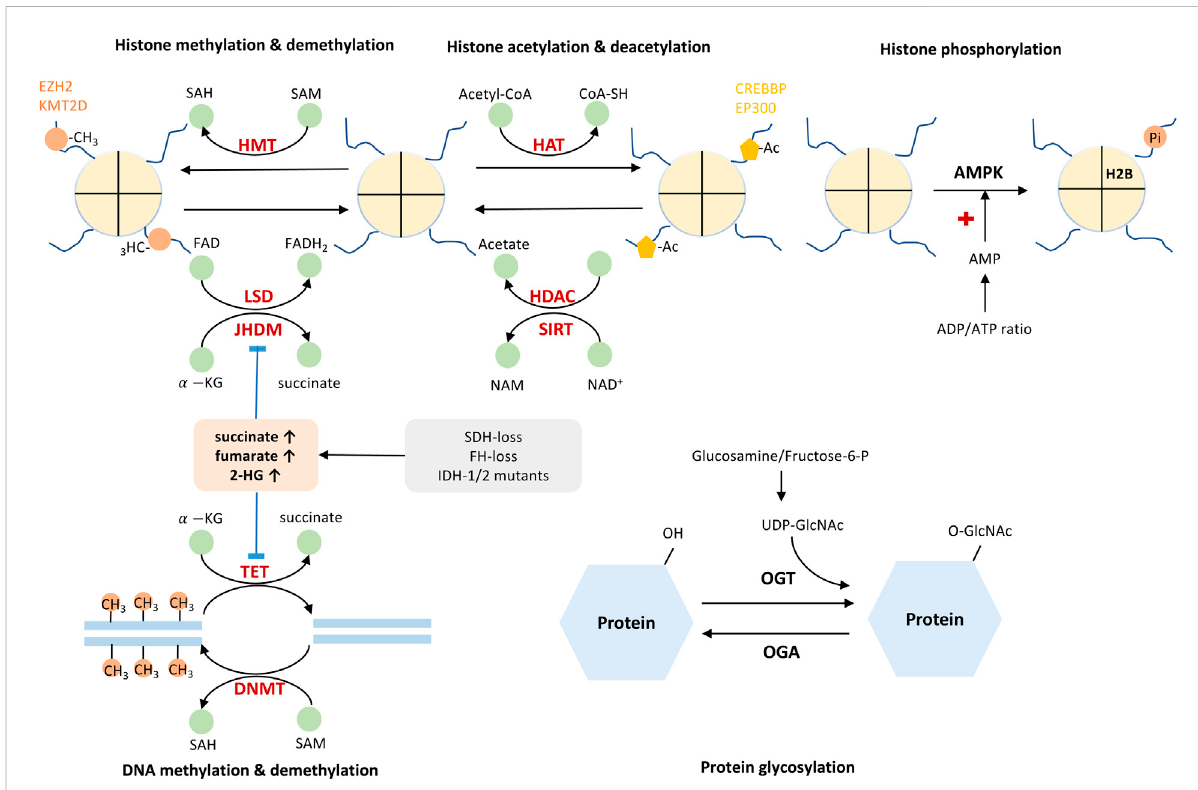
FIGURE 2 Cellular metabolites serve as co-factors or substrates for epigenetic enzymes. Addition or removal of epigenetic marks is catalyzed by epigenetic enzymes, of which process relies on several critical metabolites. SAH/SAM, NAD + /NADH, Acetyl-CoA/Co-A, ATP/ADP ratio act as important molecules or signals governing epigenetic modi fi cations. In addition, Metabolites such as succinate, fumarate, 2-HG, and lactate could inhibit the activity of epigenetic enzymes. HMT, histone methyltransferase; LSD, lysine-speci fi c histone demethylase; JHDM, Jumonji domain- containinghistonedemethylase;HAT,histoneacetyltransferase;HDAC,histonedeacetylase;SIRT,sirtuins;DNMT,DNAmethyltransferase;TET,ten- eleven translocation methylcytosine dioxygenase; SAM, S-adenosylmethionine; SAH, S-adenosylhomocysteine; α − KG, α -ketoglutarate; NAM, nicotinamide; NAD + , nicotinamide adenine dinucleotide (oxidized); FAD, fl avin adenine dinucleotide (oxidized); FADH 2 , fl avin adenine dinucleotide (reduced); FH, fumarate hydratase; SDH, succinate dehydrogenase; IDH1/2, isocitrate dehydrogenase 1/2; EZH2, enhancer of zeste 2 polycomb repressive complex 2 subunit; KMT2D, histone-lysine N-methyltransferase 2D. AMPK, AMP-activated protein kinase; Pi, phosphate group; OGT, O-GlcNAc transferase; OGA,